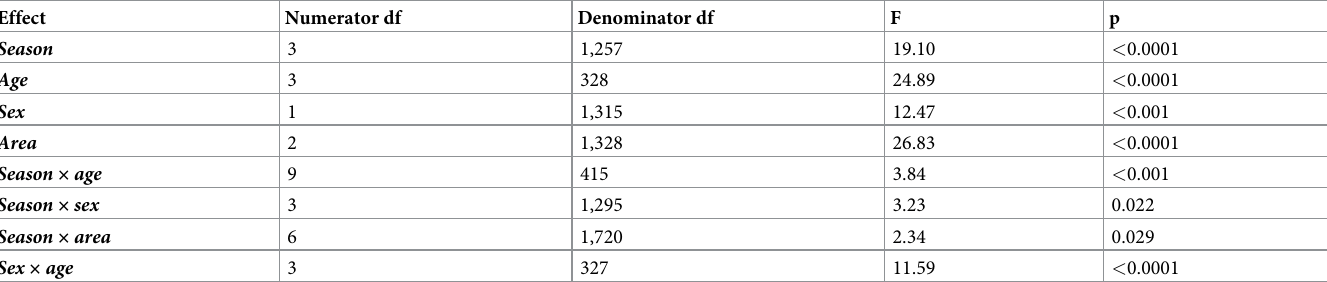
Table 6. Summary of the linear mixed model generated for the subgroup analysis.